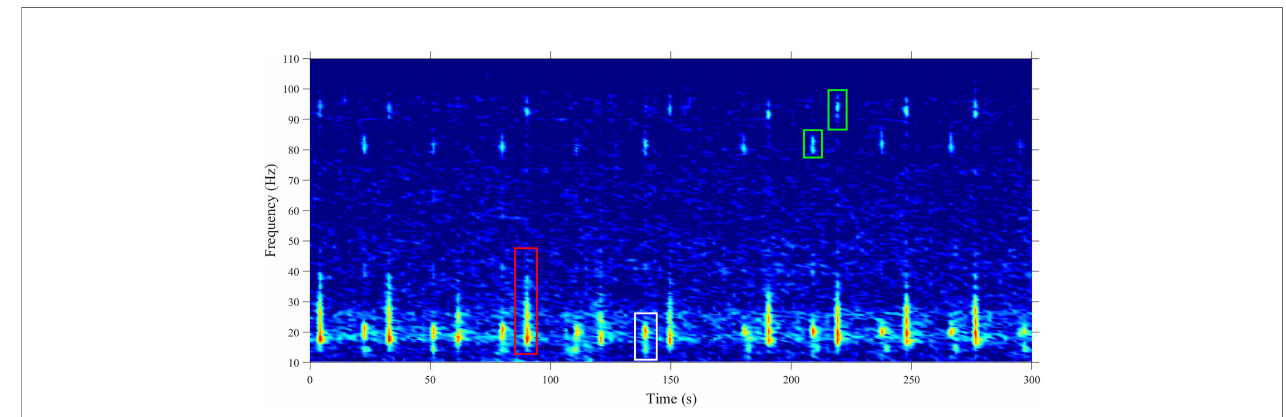
FIGURE 2 | Spectrogram of example vocalisations of the fi n whale. The 20 Hz pulse (red box), the back-beat pulse (white box) and the higher-frequency components accompanying both the back-beat and 20 Hz pulses (green boxes). Image was taken from Cape Leeuwin, (06-Aug-2011, 19:00). Spectrograms were calculated in 256-point Hann windows with 0.49 frequency resolution; sampling frequency